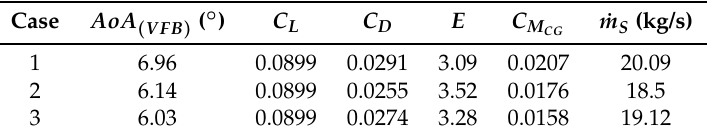
Table 8. Aerodynamic parameters and mass flow rate for the Vertical Force Balance condition (VFB) of the three CFD